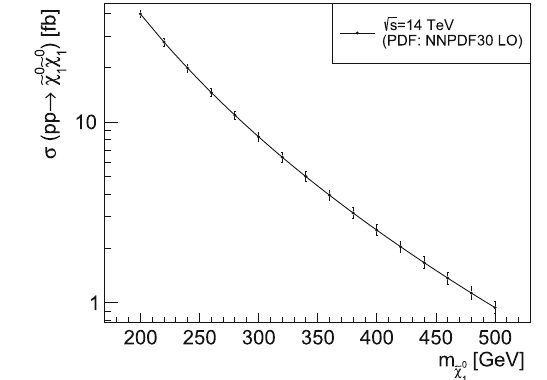
Fig. 5 Crosssectionofthedirectneutralinoproductionatleadingorder as a function of the neutralino mass m ˜ χ 0 to PDF variations and the factorisation and renormalisation scales